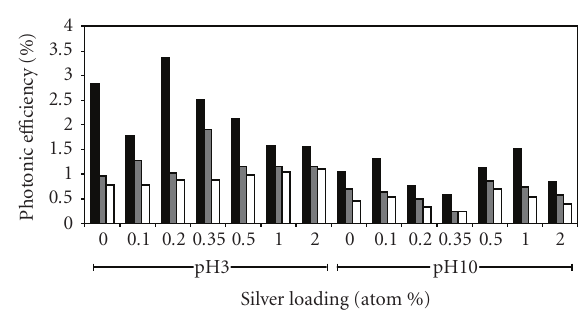
Figure 8: E ff ect of recycling Ag-TiO 2 photocatalysts on observed photonic e ffi ciencies at pH 3 and pH 10 (1st run (cid:2) , 2nd run , and 3rd run (cid:3) ), degradation of 1mM DCA without any extra addition of chloride ions or washing technique performed. The photocatalyst concentration was 0.5 g/L with di ff erent silver loadings (atom%).